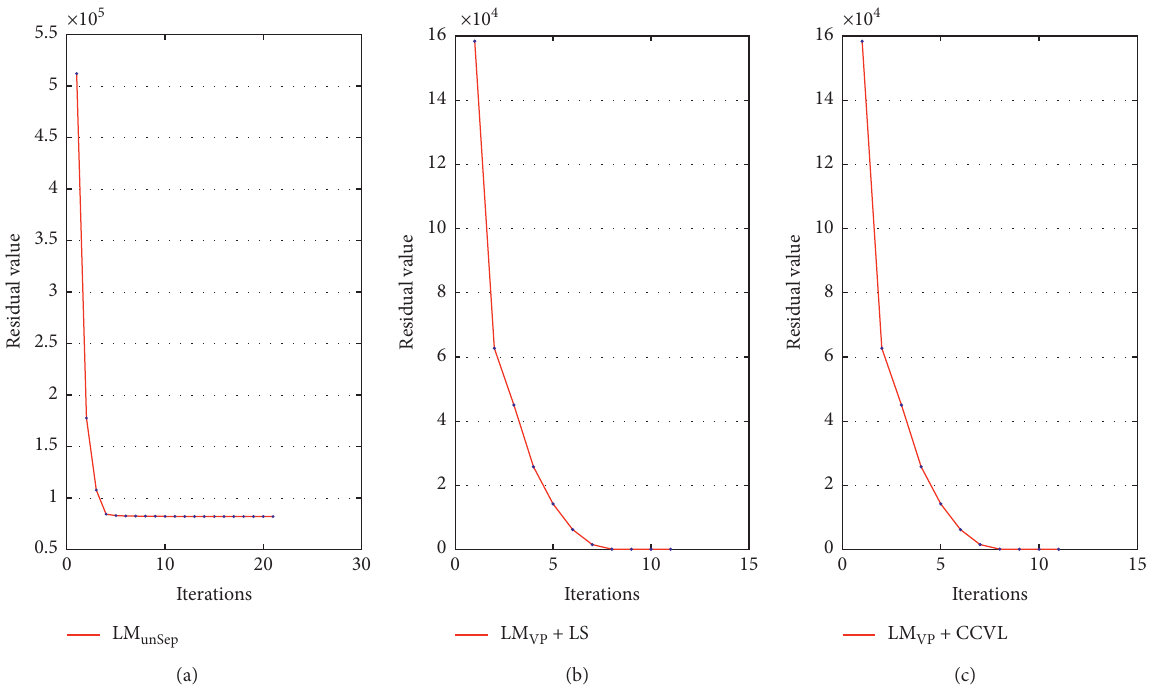
Figure 9: Residual changes of the LM unSep , LM VP + LS , and LM VP + CCVL methods in the iteration process of Example